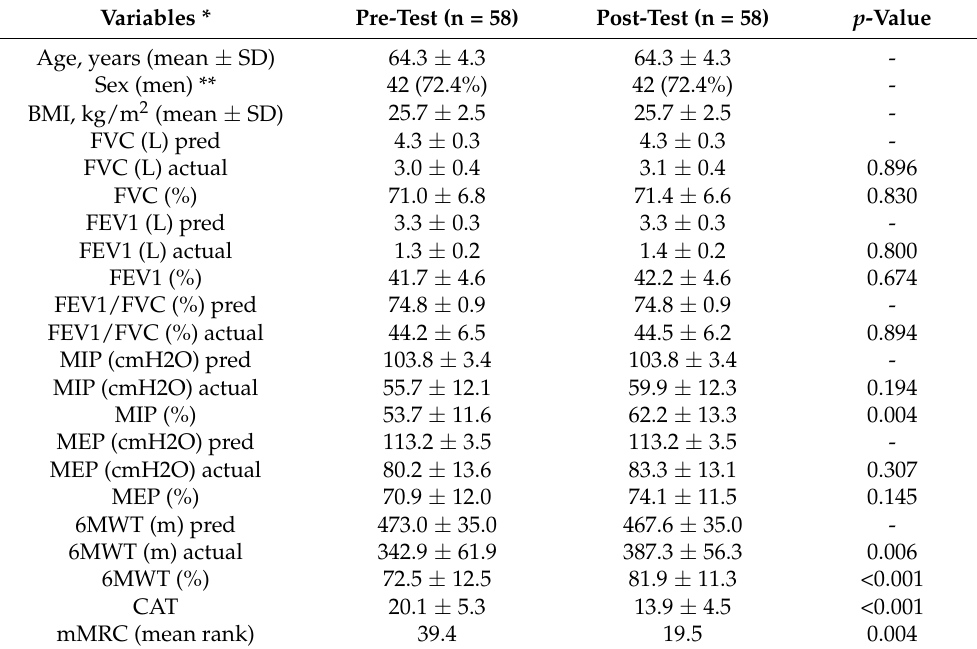
Table 2. Comparison of pre-test and post-test in the online setting.